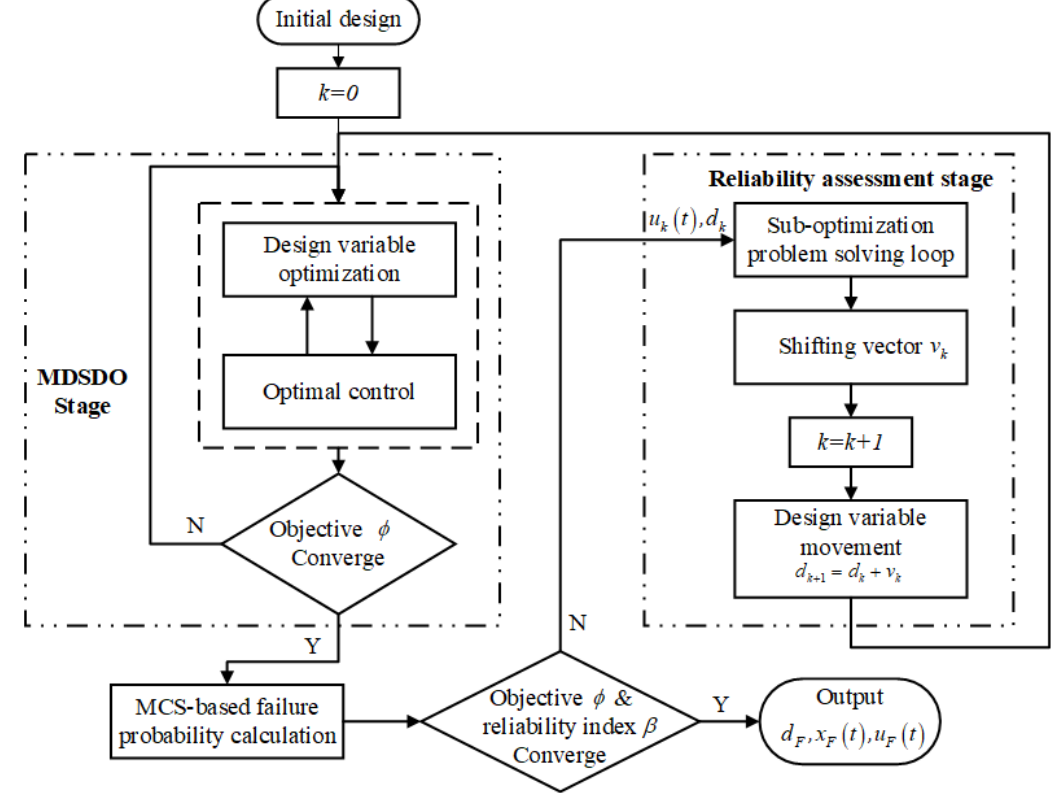
Figure 3. The algorithm flowchart of the proposed approach.